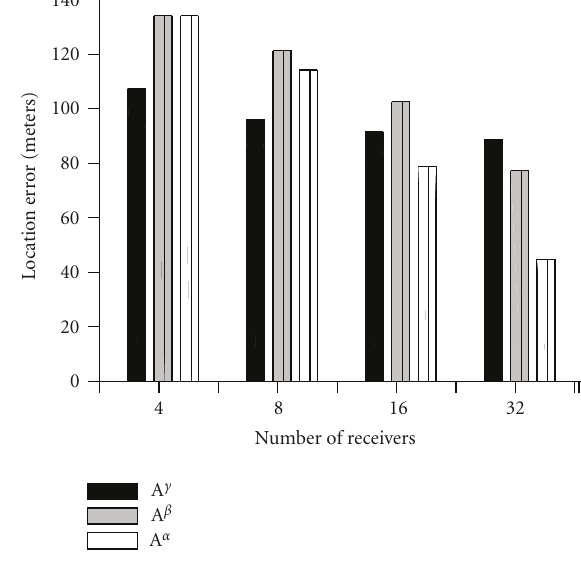
Figure 8: Location error for C = 0 .